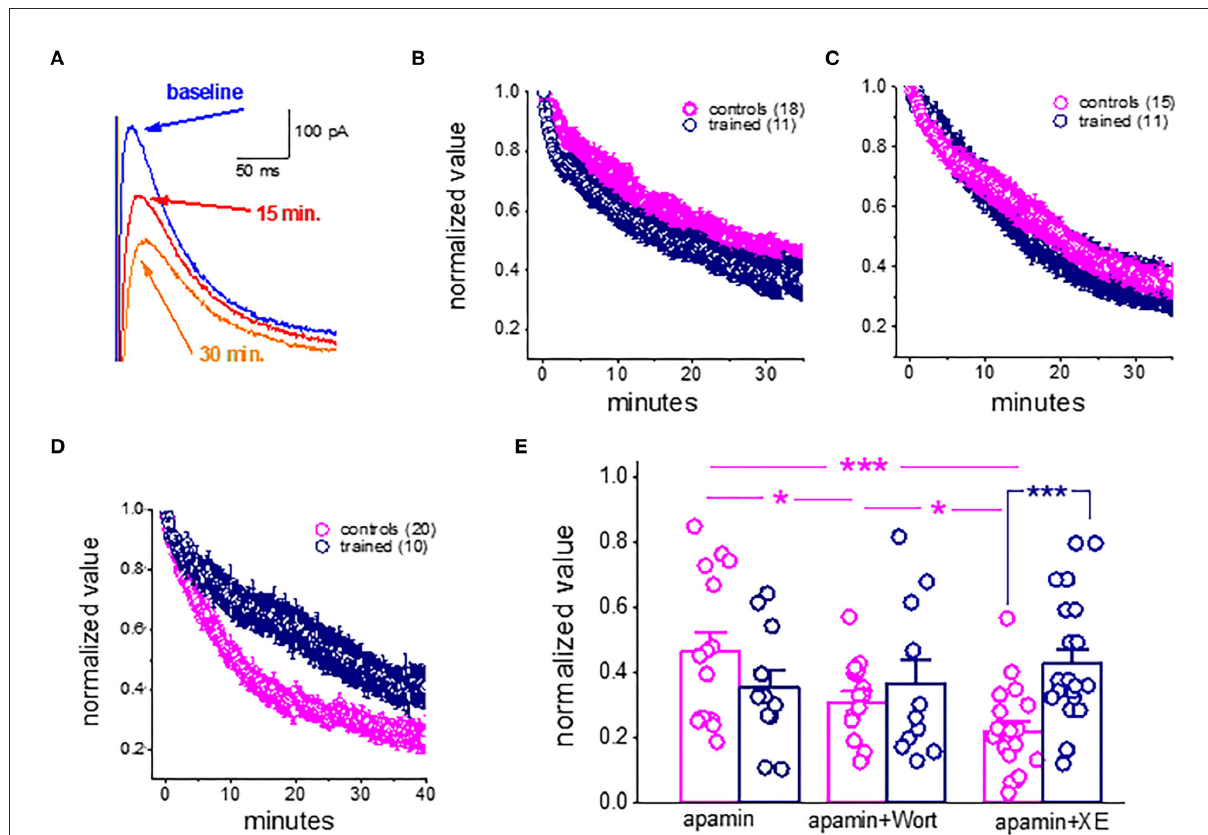
FIGURE4 Rundown of the sI AHP upon prolonged recordings shows that the M current is not active in piriform cortex pyramidal neurons after learning. (A) Whole-cell voltage-clamp recordings from a pyramidal neuron. The cell was voltage-clamped at − 60mV. A 200-ms depolarizing pulse to + 60mV generated an unclamped calcium current (truncated). After its termination, an outward current appears with a reversal potential of − 80mV. Traces illustrating the rundown of the sI AHP . The blue trace shows the sI AHP when the stable recording was established. Red and orange traces were taken after 15 and 30min. (B) Summary plot illustrating the rundown of the sI AHP in neurons from trained and control rats. Recordings were carried out in the presence of the SK channel blocker apamin, to ensure that only the sI AHP is activated. (C) Rundown of the sI AHP in the presence of apamin and wortmannin, to inhibit PtdIns(4,5)P(2) biosynthesis. (D) Rundown of the sI AHP in the presence of apamin and XE991, to block the cholinergic M current. (B,D) values represent mean ± SE, and n denotes the numbers of neurons. (E) Bars show the average normalized decline for each treatment. In apamin only, there was no difference in the rundown kinetics between the controls and trained neurons. The presence of wortmannin enhanced the sI AHP rundown in neurons from controls only. Application of the M current blocker greatly enhanced the sI AHP decay in neurons from controls only. Notably, both treatments had no effect on the sI AHP decay in neurons from trained rats. * p < 0.05. *** p < 0.001. The paired t -test was used to compare the effect of drug application on each group of neurons. The unpaired t -test was used to examine the difference between neurons from trained and control